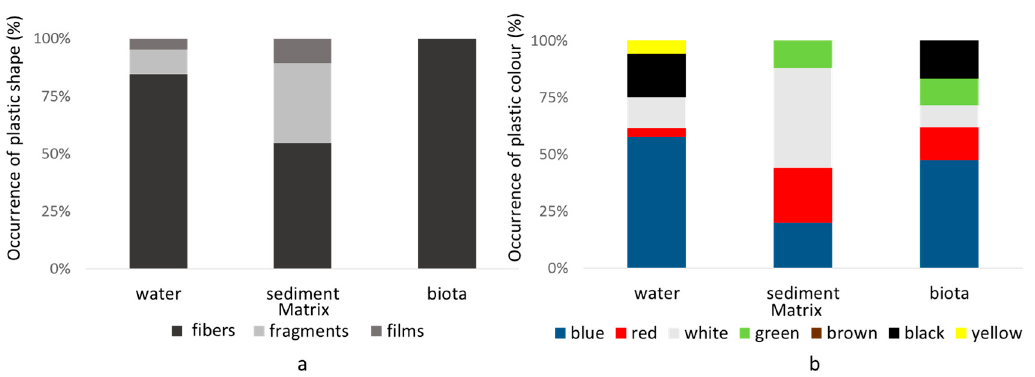
Figure 3. ( a ) Frequency of plastic shapes in water, sediment and biota (caddisfly cases), ( b ) frequency of colors in water, sediment and biota (caddisfly cases).